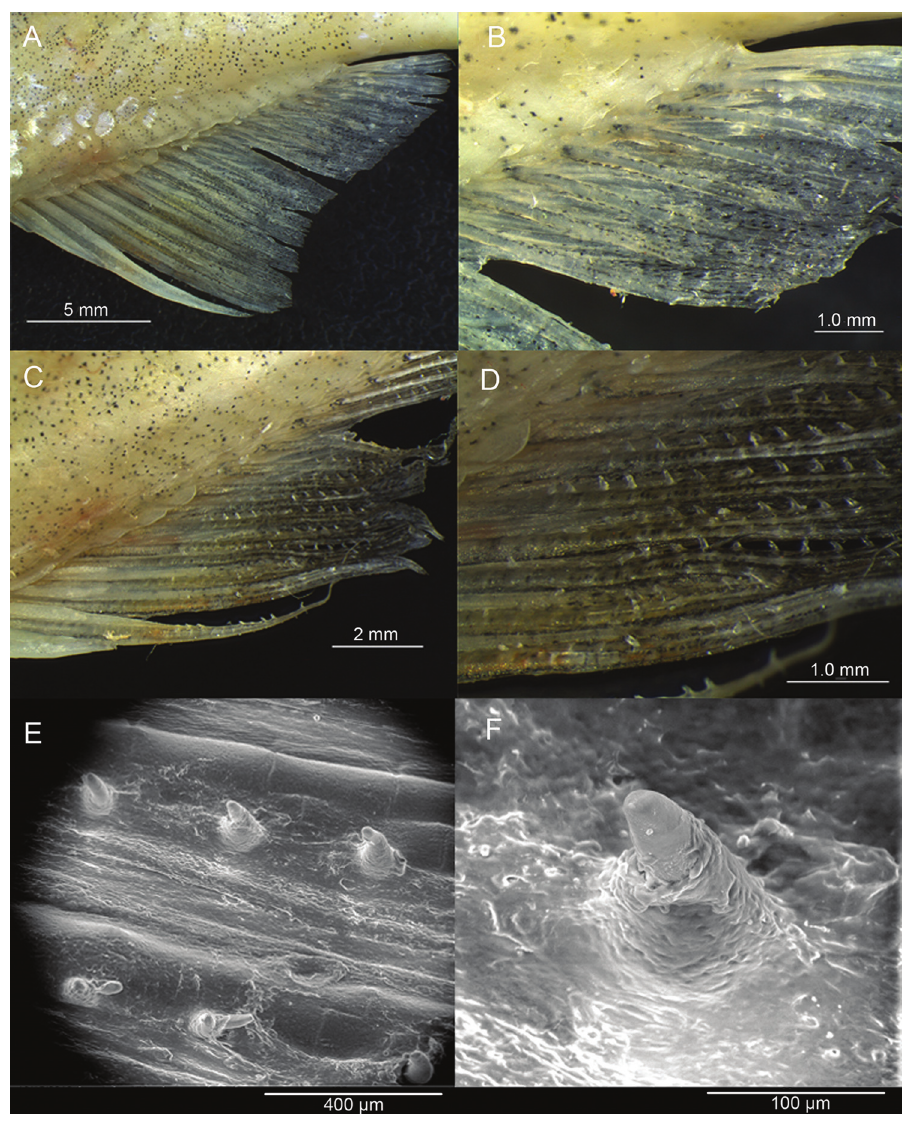
Fig. 4. Details for the anal fin of male of A. aff. scabripinnis with and without hooks. A : Anal fin of male from Ribeirão Grande (662 m a.s.l.); B : detail of fin without hooks; C : Anal fin of male from Ribeirão Grande (1850 m a.s.l.); D : detail of fin with hooks; E and F : Scanning electron micrography showing hook in